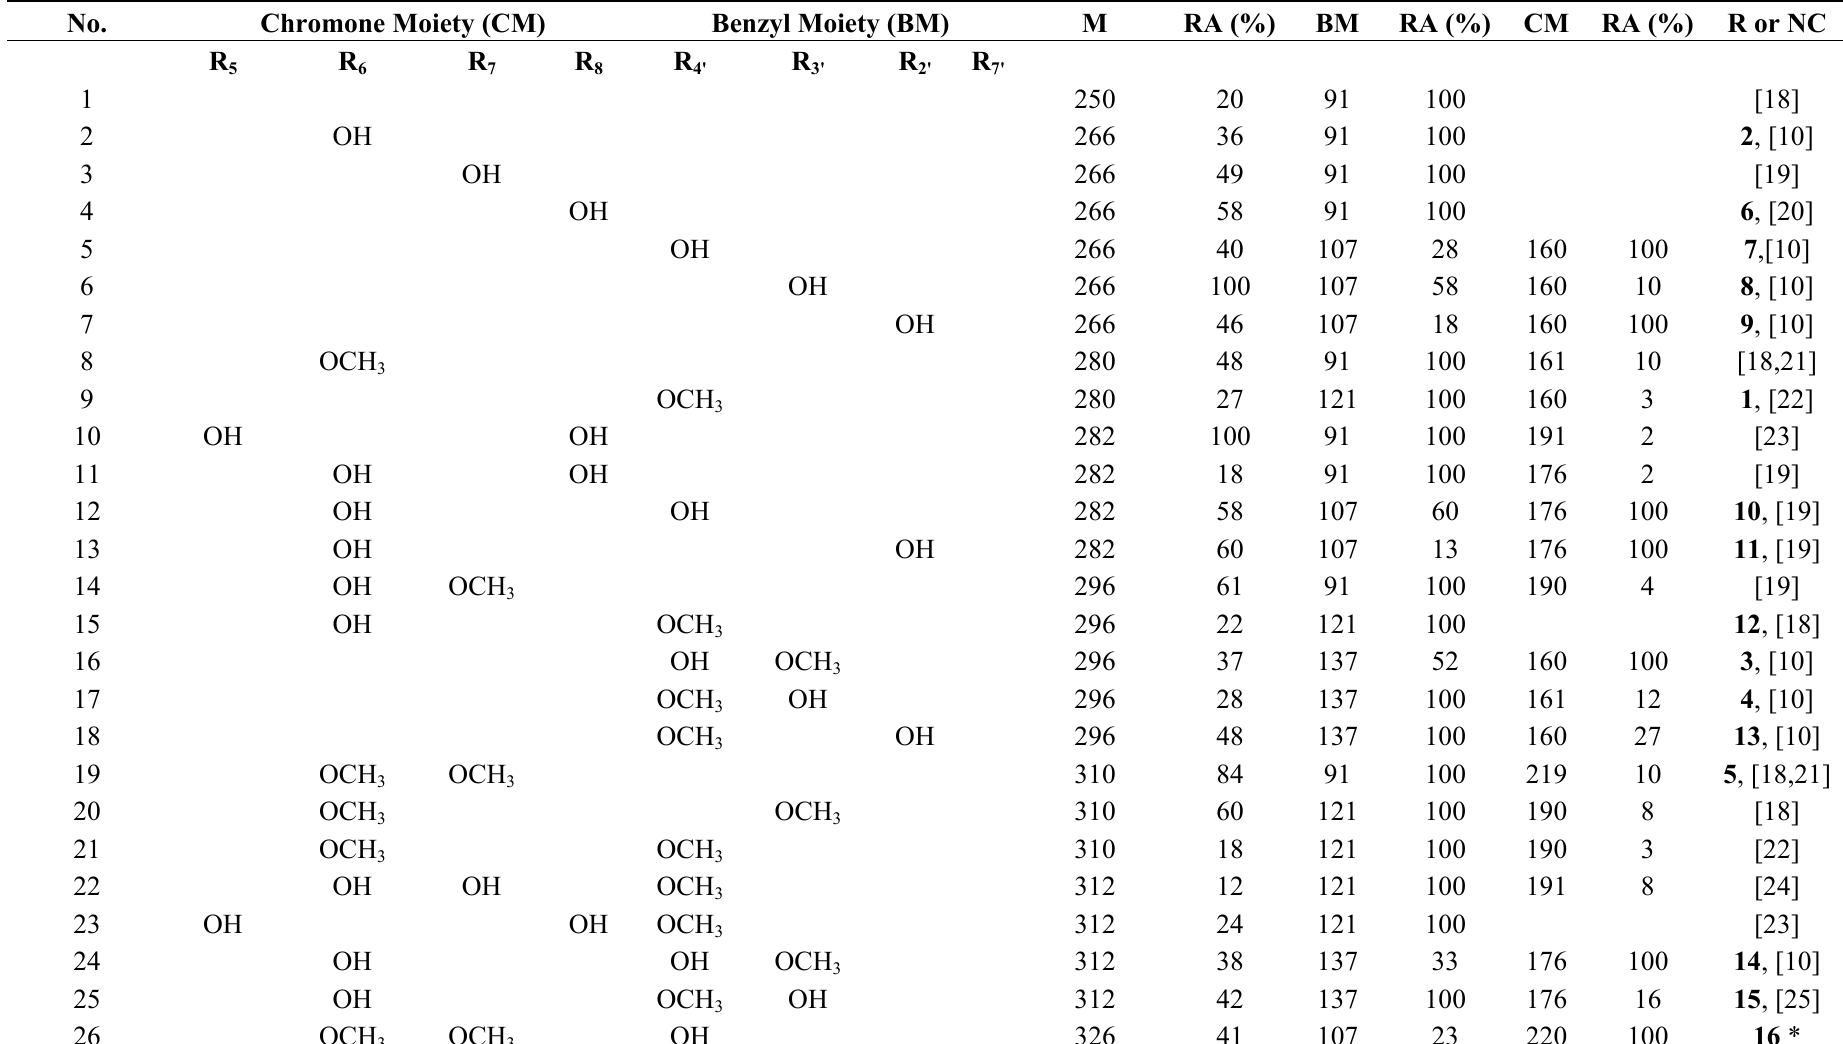
Table 1. MS characterization of 2-(2-phenylethyl)chromones in